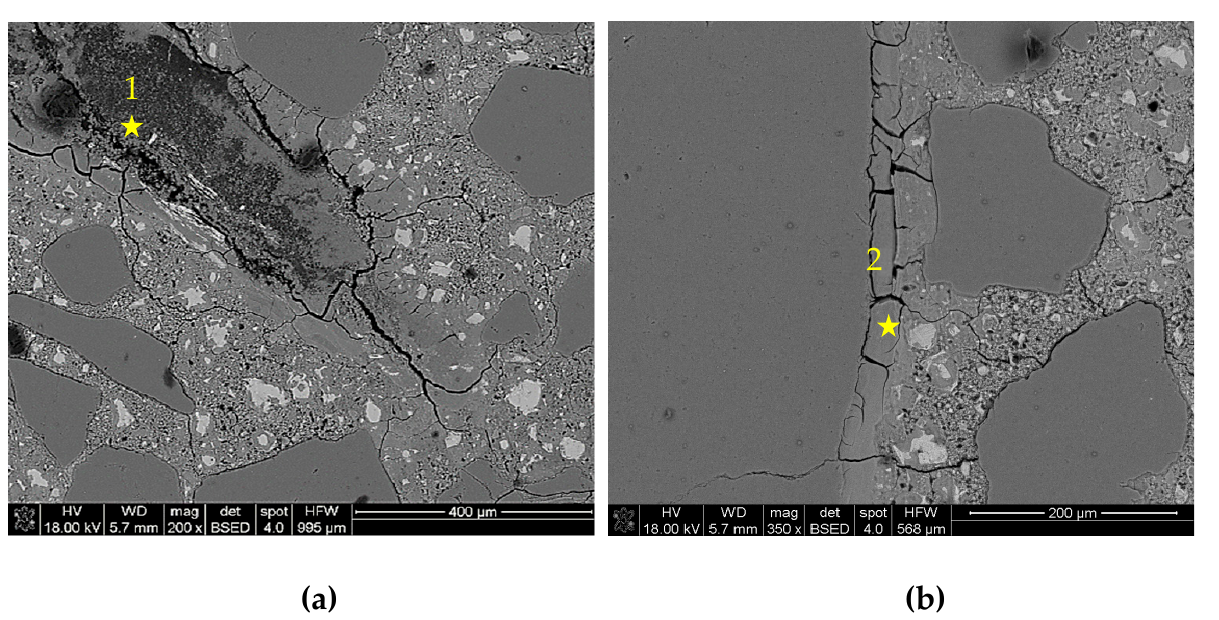
Figure 5. Microstructure images of control mortars: ( a ) gel in reactive aggregate; ( b ) gel located in ITZ. X-ray microanalysis at location 1 – 2 (see Table 4).